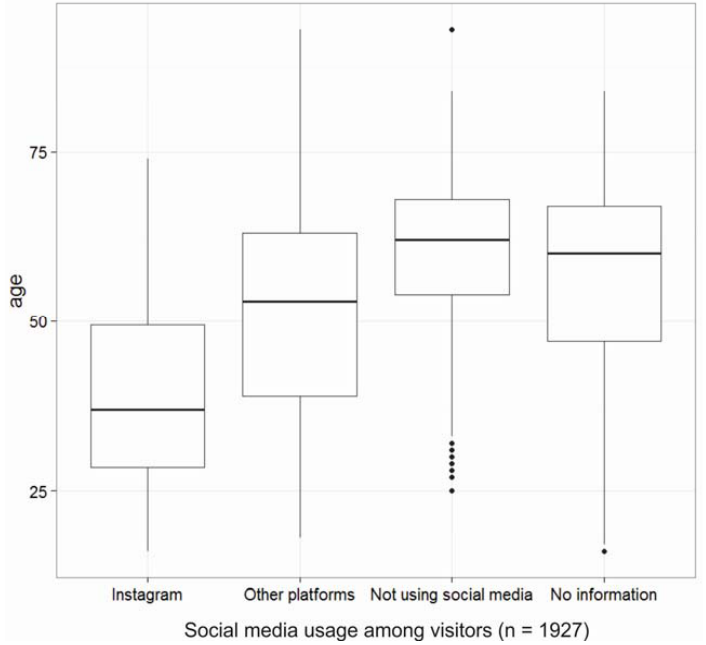
Figure 3. Boxplots showing the age distribution for different groups among the survey respondents ( n = 1927). Each box indicates the median, the first quartile, the third quartile, and the full range (vertical line and dots) of respondents’ age in each group. Groups in the figure are non-overlapping. For example, if a responded used both Instagram and Facebook, they are counted only as Instagram-users in the boxplot.